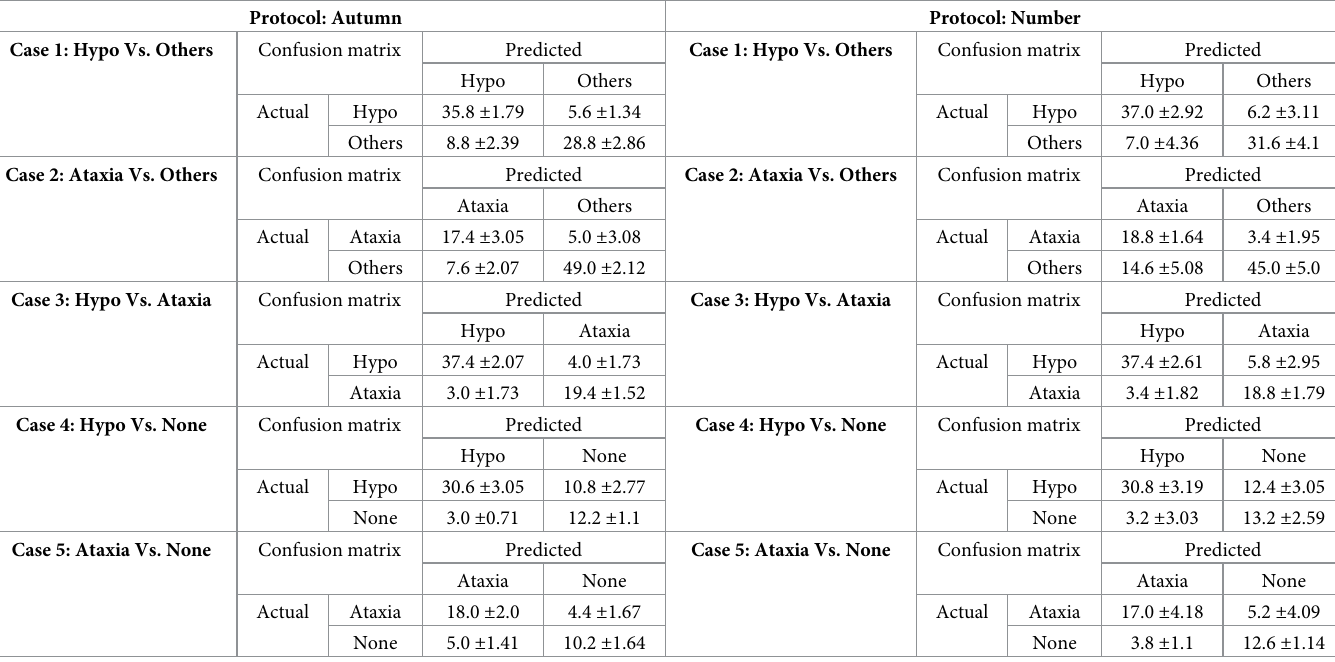
Table 5. Confusion matrices for the proposed